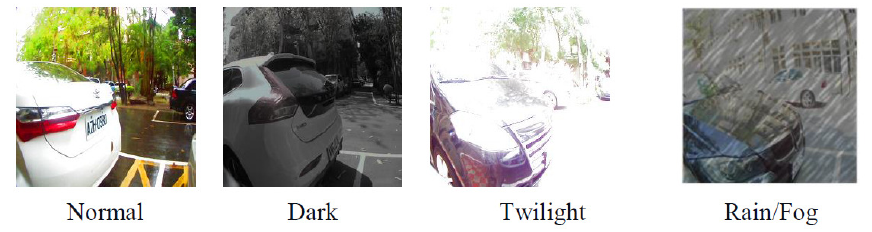
Figure 14. Bad condition tests on rain/fog, twilight, and dark.